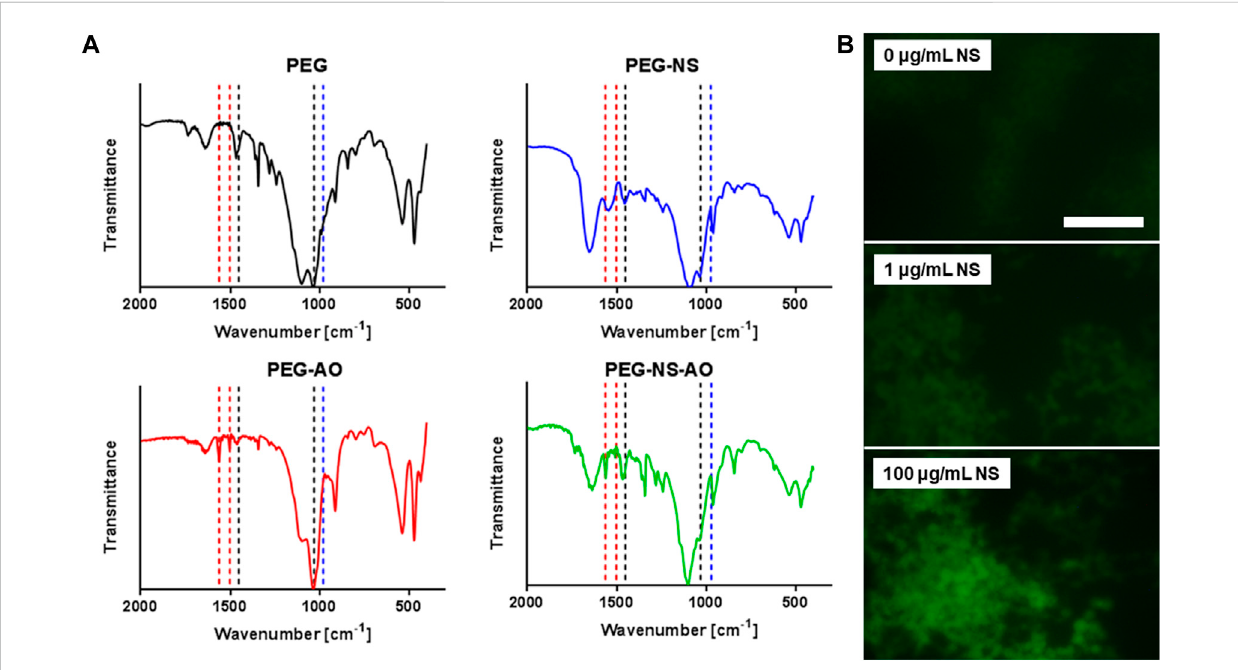
FIGURE 3 Con fi rmation of NS and AO Hydrogel Microsphere Encapsulation. (A) FTIR spectra of microspheres containing PEG-only, PEG-NS, PEG-AO, and PEG-NS-AO. Black drop lines indicate peaks representative of PEG, blue drop lines represent peaks indicative of NS, and red drop lines are for peaks typical of AO. (B) Fluorescent images of PEG microspheres containing 0.1 mM AO and 0, 1, or 100 μ g/mL NS following buffer exchange and sonication. Scale bar = 50 μ